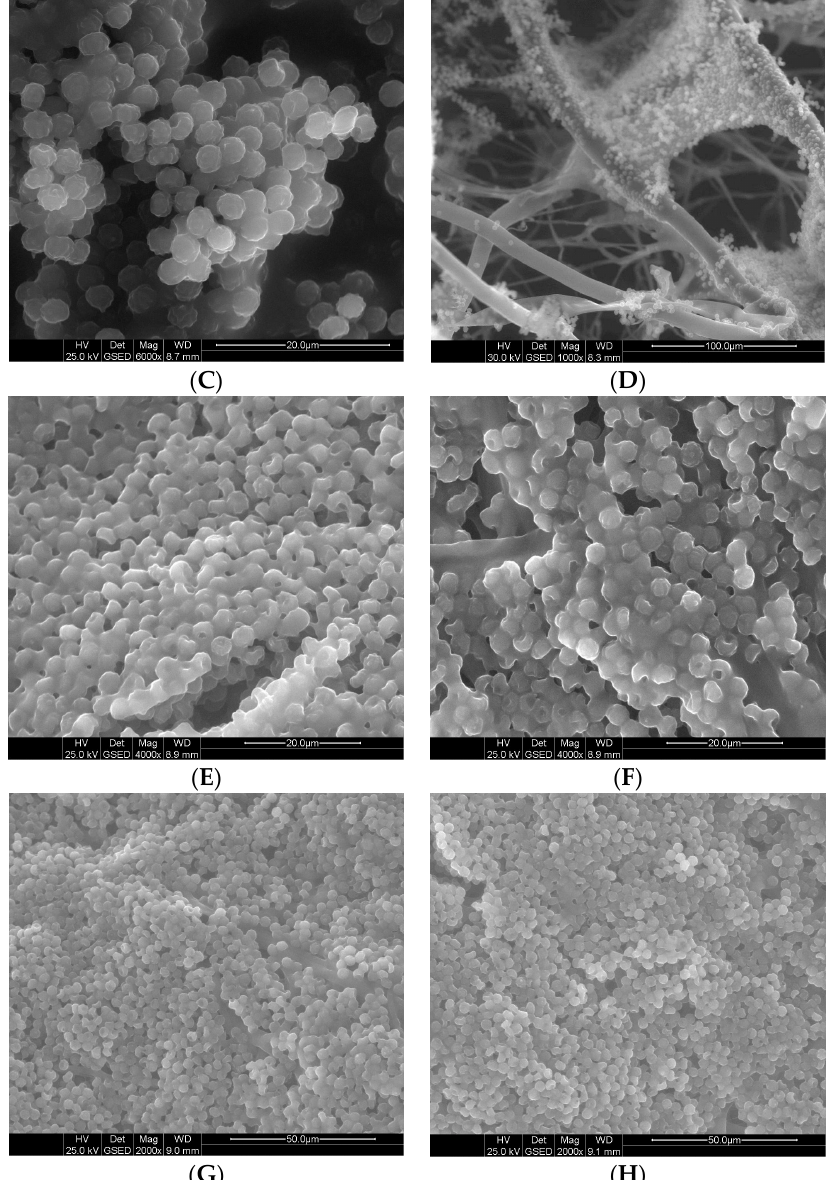
Figure 2. Changes in morphology of conidia: control sample without biocide after 4 h ( A ) and 24 h ( B ); with cationic GS C6 at ½ MIC after 4 h ( C ) and 24 h ( D ); sample with cationic GS C6 at MIC after 24 h ( E ); sample with non-ionic GS A6 at MIC after 24 h ( F ); sample with cationic GS C6 at 2 MIC after 24 h ( G ); sample with non-ionic GS A6 at 2 MIC after 24 h ( H ).